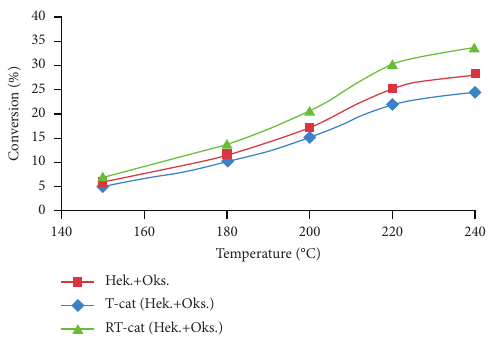
Figure 3: Temperature dependence of the conversion of hexane in air at different phases.